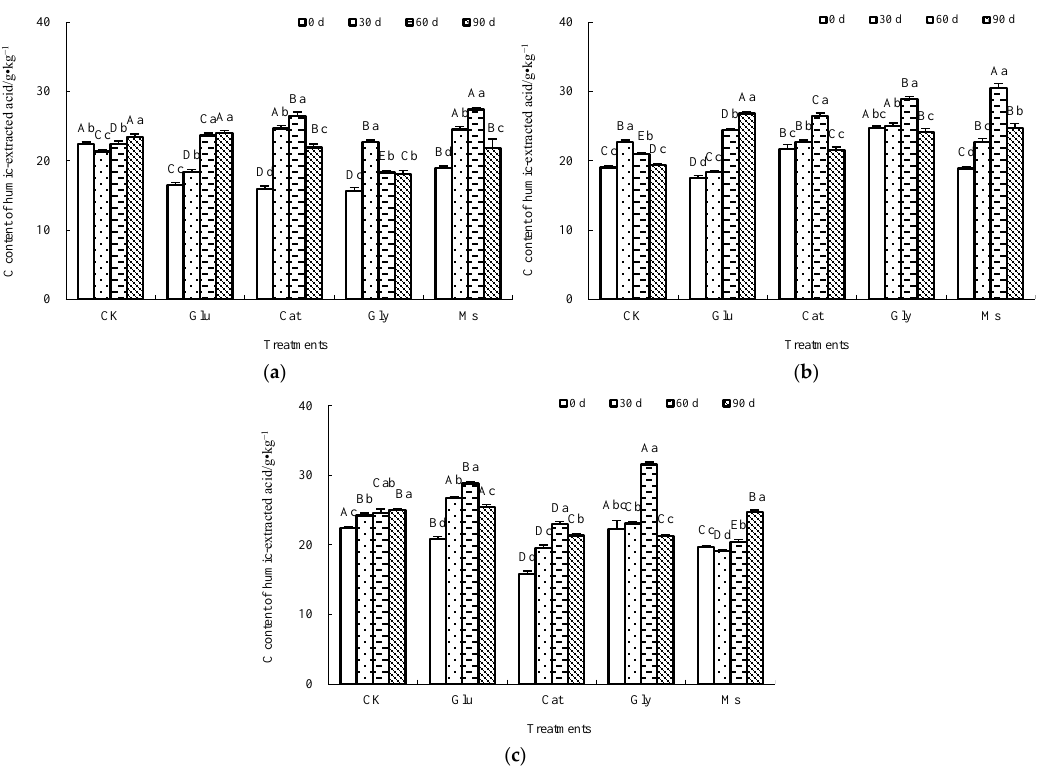
Figure 1. Effect of Maillard reaction precursors on C HLE extracted from the decomposing material of rice straw at three incubation temperatures. Note: significant difference in the different treatments with the same number of incubation days is indicated by different capital letters, and significant difference in the different incubation days under the same treatment is expressed by different lowercase letters. ( a ) Incubated at 10 °C; ( b ) incubated at 15 °C; ( c ) incubated at 28 °C.